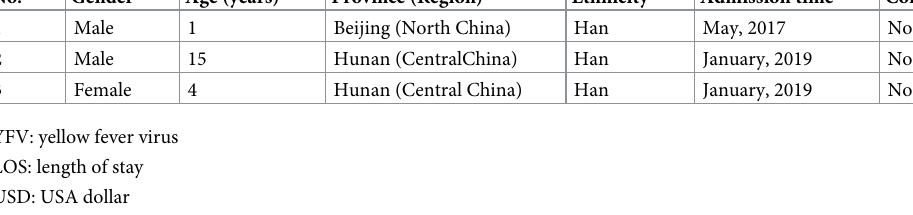
Table 7. The general sociodemographic characteristics and disease burden of imported YFV infection during pediatric inpatient hospitalizations from December 2015 to December 2020.